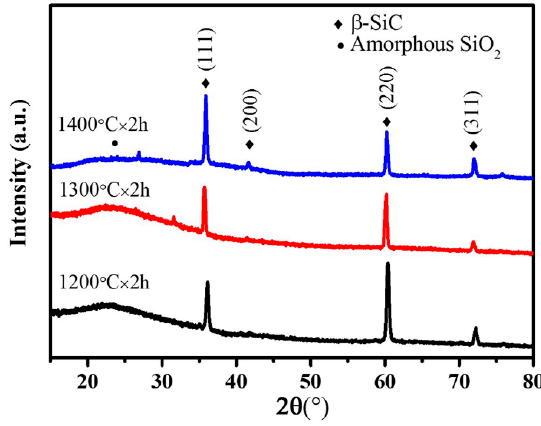
Figure 3. X-ray diffraction (XRD) patterns of the as-received samples.